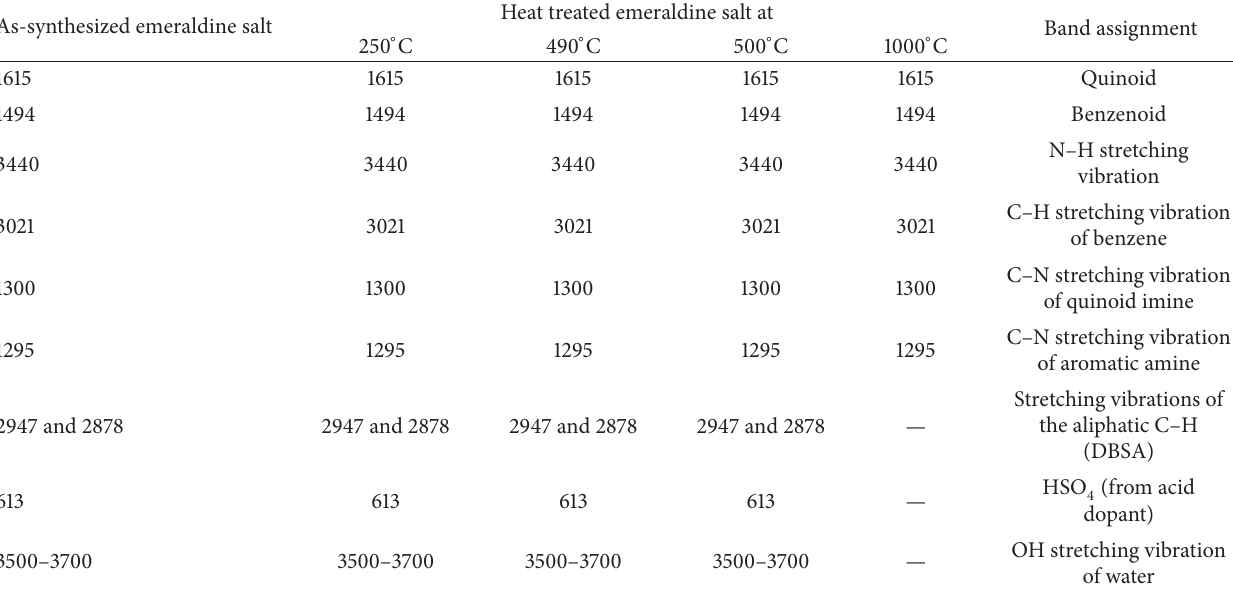
Table 1: Vibrational bands in FT-IR spectra of emeraldine salt.